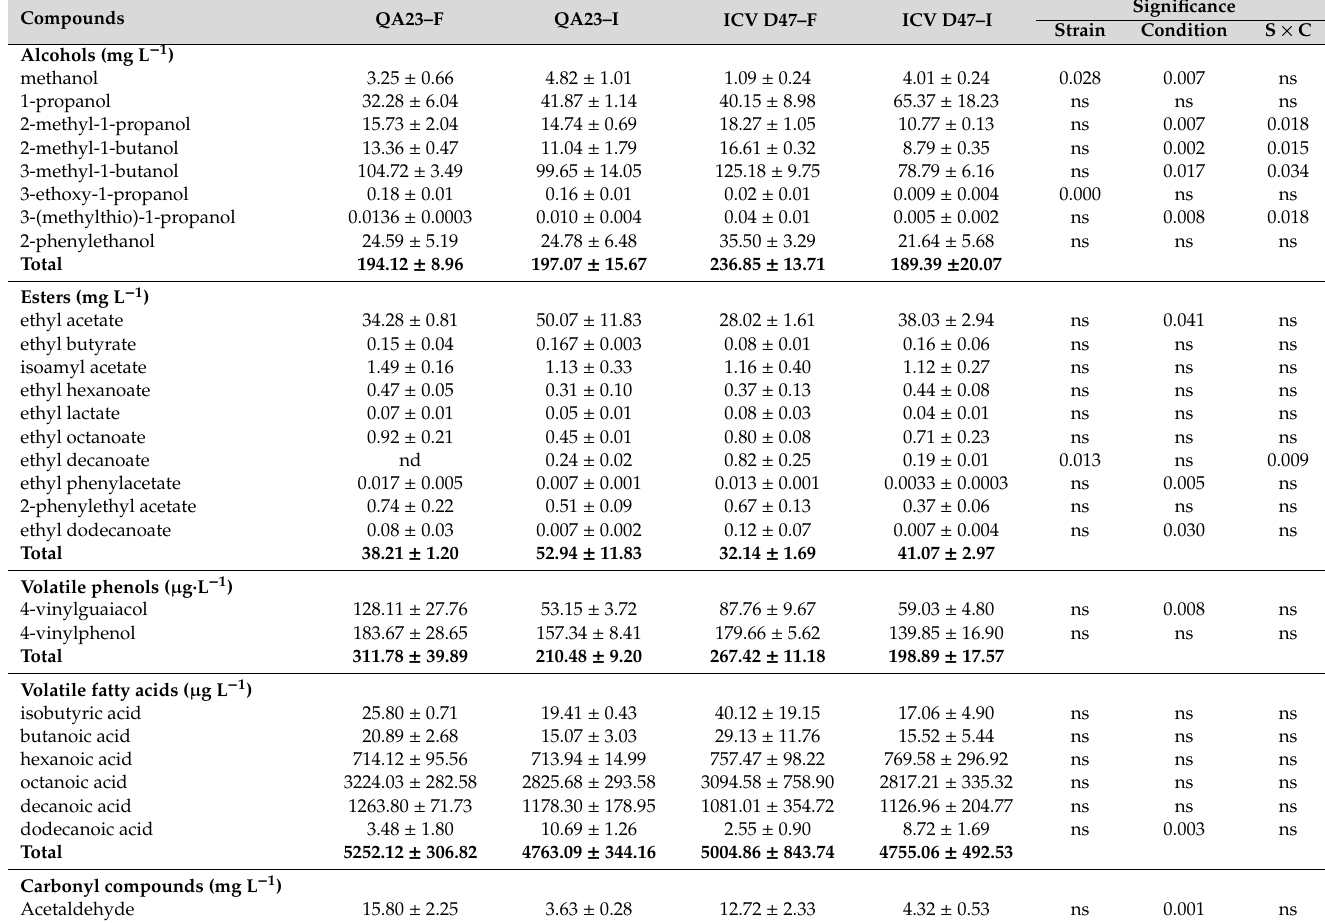
Table 3. Concentration of volatile compounds (mean values and standard deviation) of mead fermented by S. cerevisiae QA23 and ICV D47 with free cells (F) or immobilized cells (I) and significance of the factors strain (S) and condition (C) according to two-way